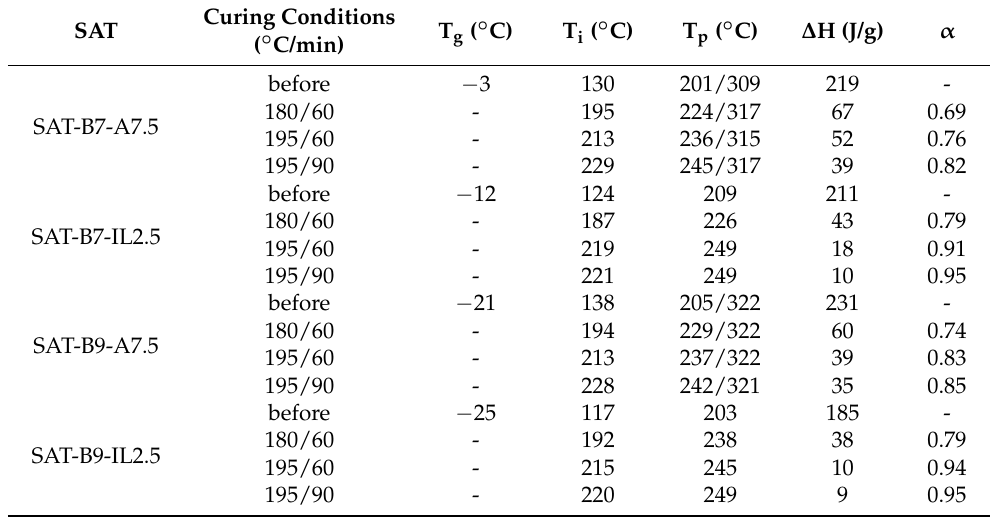
In general, α values are higher for thermally cured SATs with the ionic-liquid-type hardener (from 0.79 to 0.95 a.u.). However, α values for samples with the amine hardener are lower (from 0.69 to 0.82 a.u. for SAT-B7 and from 0.74 to 0.85 a.u. for SAT-B9). The lower value of the α parameter is probably caused by the denser polyacrylate network formed during the UV-cross-linking process in the presence of the amine-type additive.